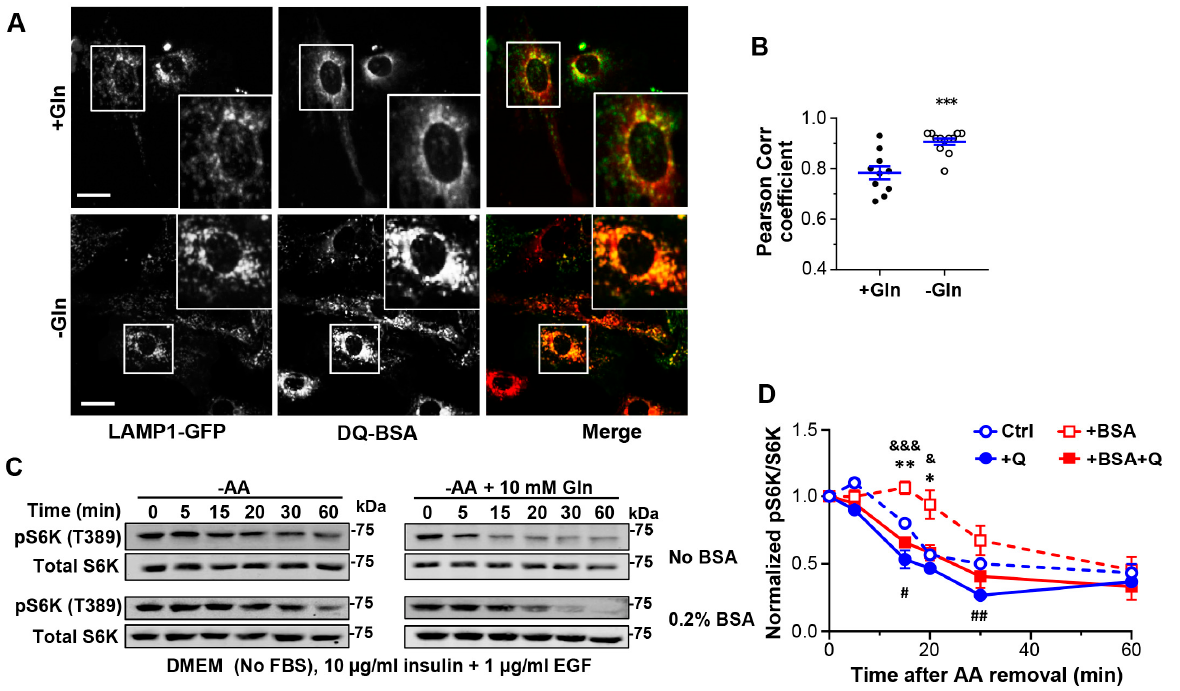
Figure 7. Glutamine deprivation enhances protein endocytosis to sustain mTORC1 activity. ( A ) Rep- resentative images of DQ-BSA ( red ) taken up by MEF cells expressing LAMP1-GFP ( green ). Cells were exposed to DQ-BSA in medium containing 4 mM Gln (+Gln) or no Gln (-Gln) for 1 h. ( B ) Sta- tistical analysis of the Pearson correlation coefficient between DQ-BSA and LAMP1-GFP for ( A ). Data points were from 3–4 coverslips with 3 areas of each coverslip, *** p < 0.001 by t test . ( C ) Rep- resentative Western blot analysis of pS6K (T389) and total S6K of MEF cells cultured in serum-free